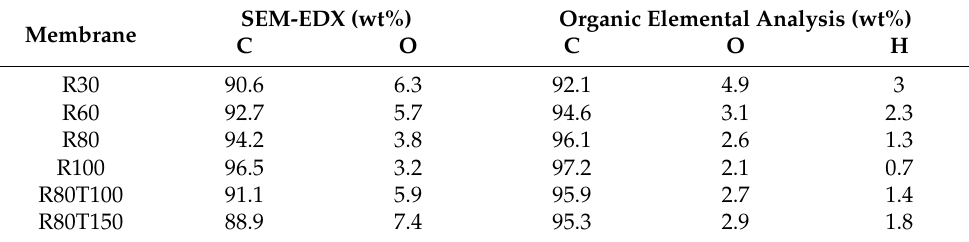
Table 2. Composition of the CMSM prepared at various polymerization temperatures.